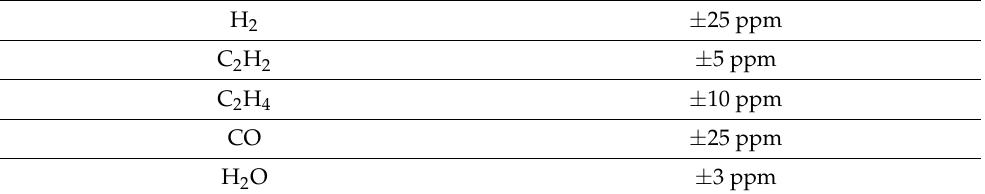
Table 18. Gas measurement precision from Hydrocal.